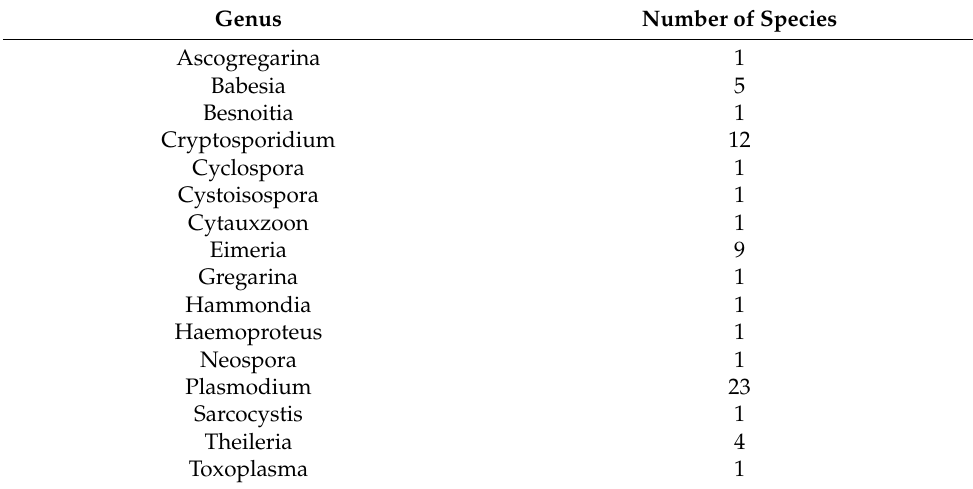
Table 1. Number of species used in the presented study, according to their phylogenetic classification based on NCBI Taxonomy [13].